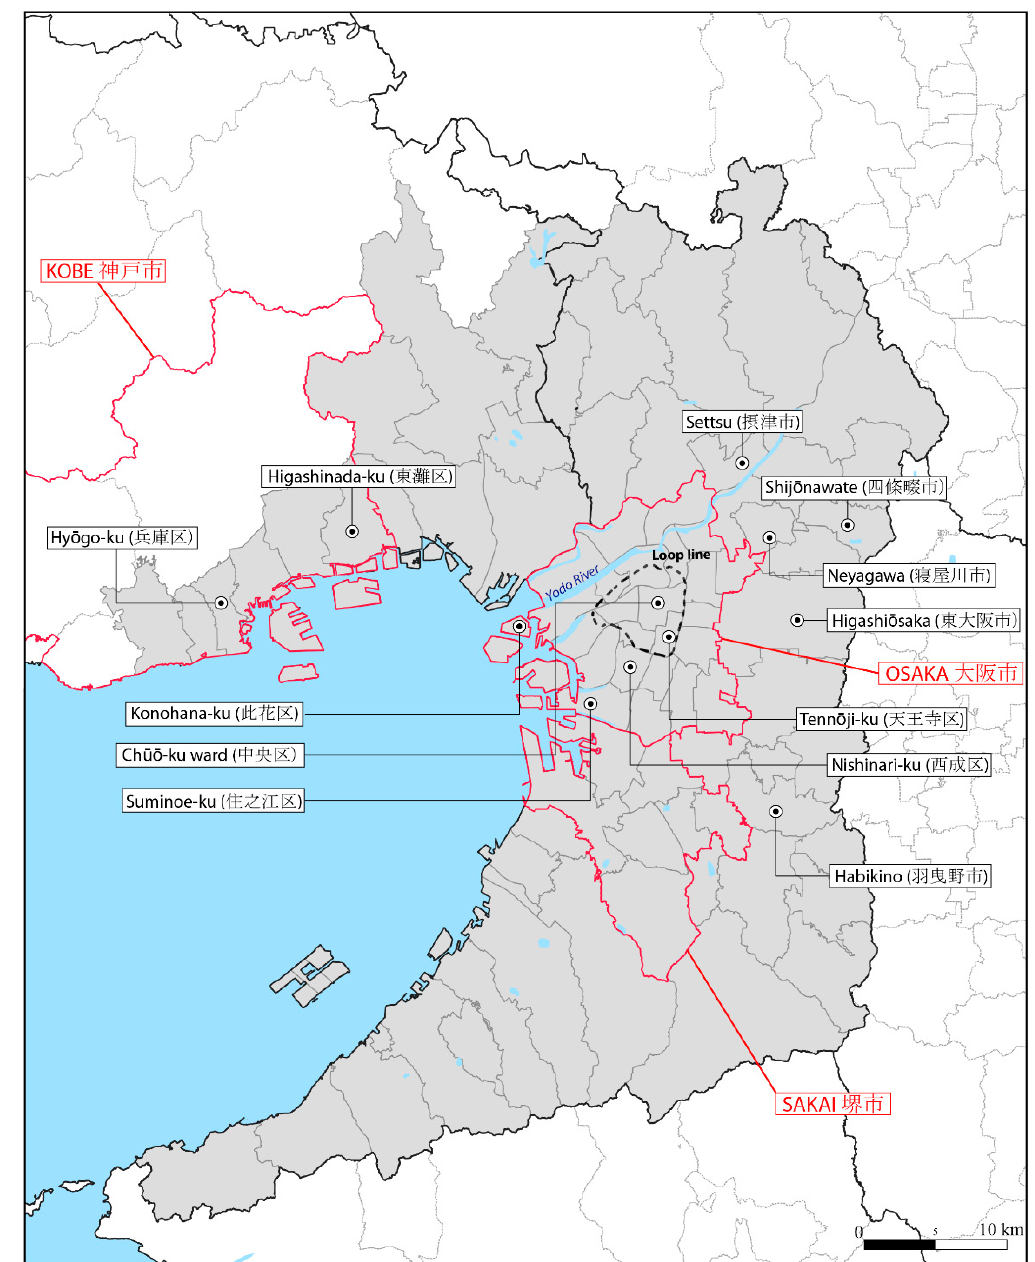
Figure A1. Case Study (In Grey) and Fieldwork Locations .